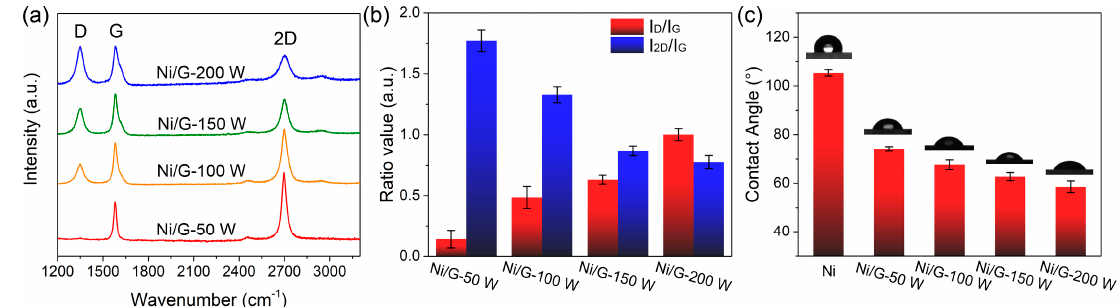
Figure 2. ( a ) Raman spectra of graphene of Ni/G electrode formed under different plasma power. ( b ) ( b ) I d / I G ratio and I 2D / I G ratio of Figure 2a. ( c ) Water contact angle of as-deposited Ni layer and I D /I G ratio and I 2D /I G ratio of Figure 2a. ( c ) Water contact angle of as-deposited Ni layer and Ni/G Ni / G electrodes.